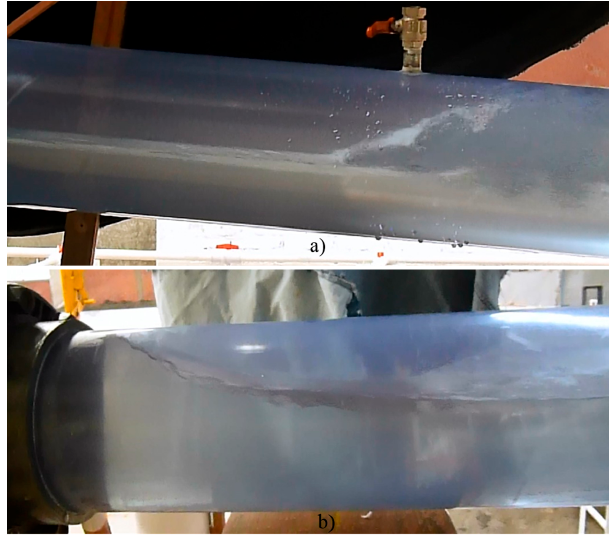
Figure 6. Flow profiles underneath the air pocket: ( a ) S2 supercritical; and ( b ) A2 subcritical.